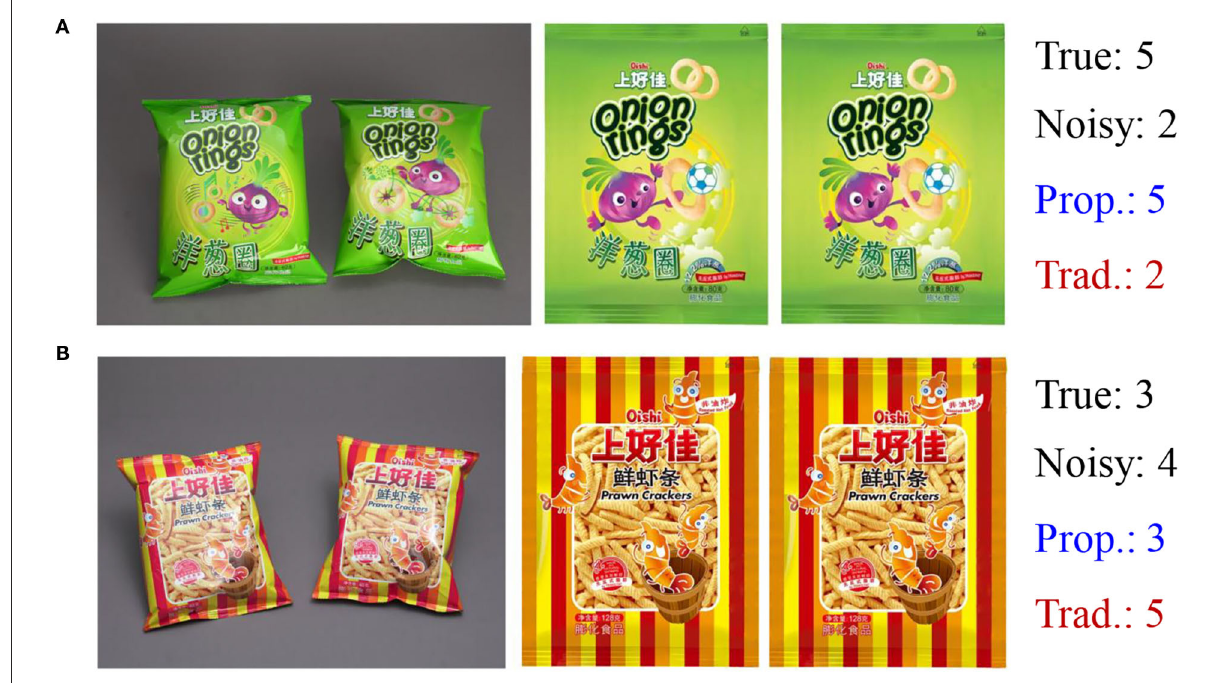
FIGURE5 Illustrative examples of the results: (A) one design with a score of 5 in the test set; (B) one design with a score of 3 in the test